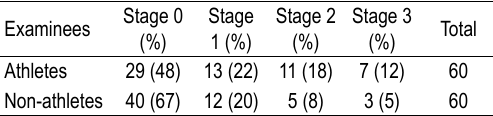
Table 3. analysis of clinical stages of examinees with